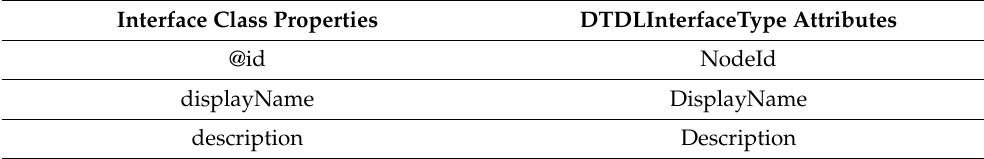
Table 4. Mapping of Interface class properties into OPC UA DTDLInterfaceType